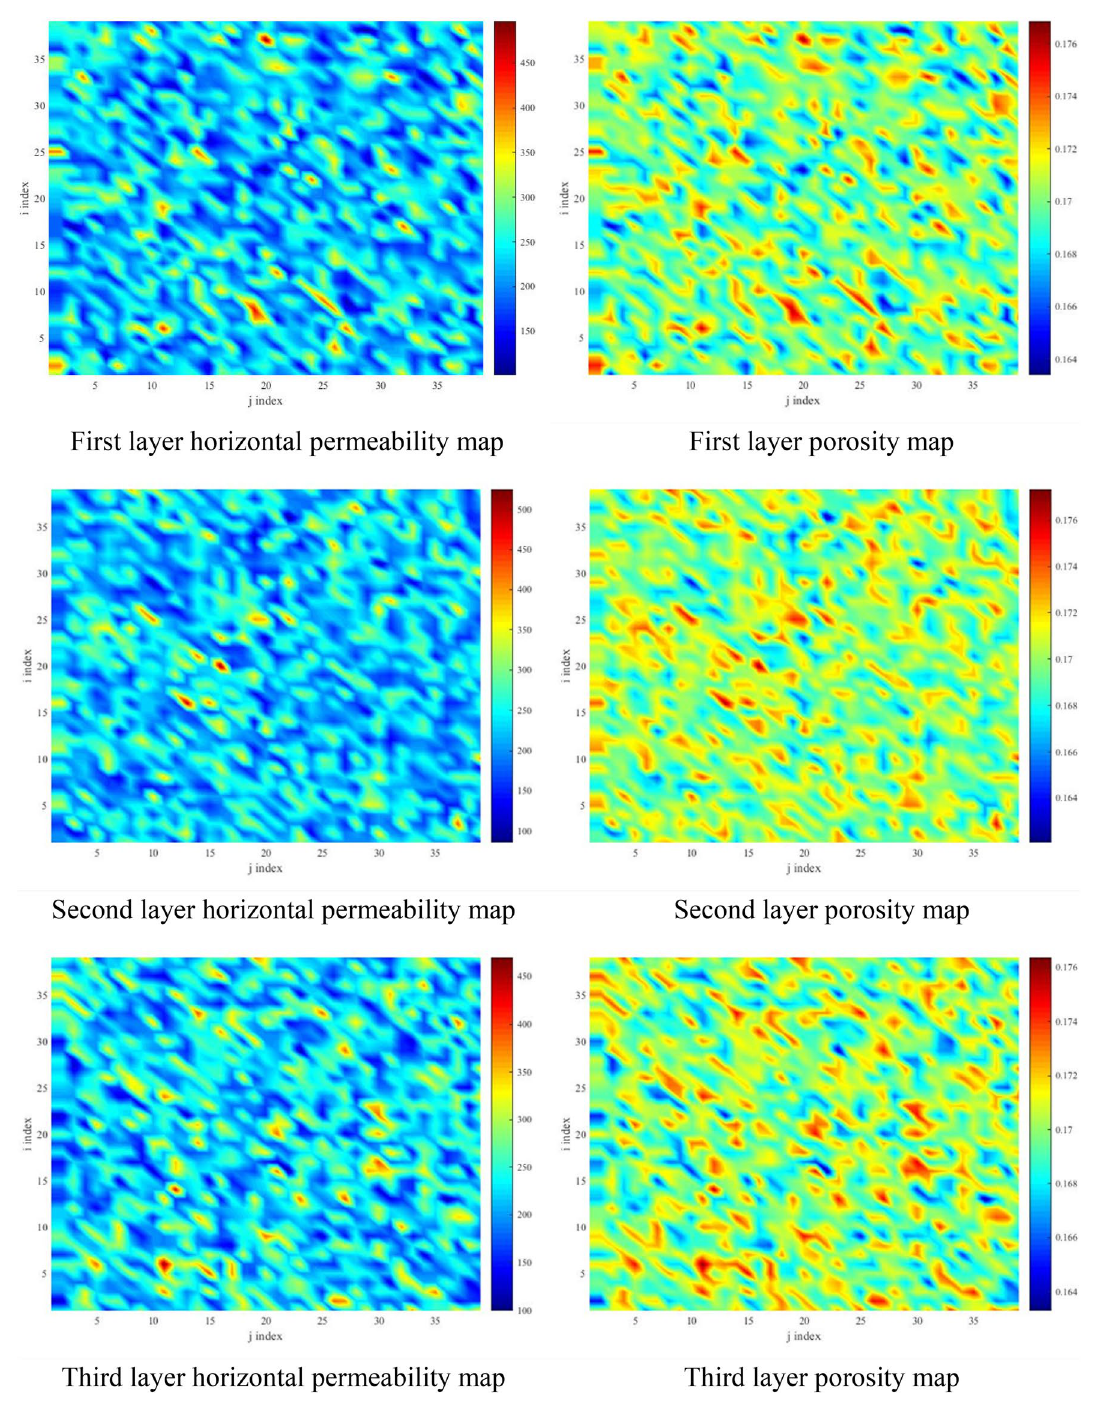
Fig. 3 Permeability and porosity distribution map. Right side: X -direction permeability map, left side: porosity distribution